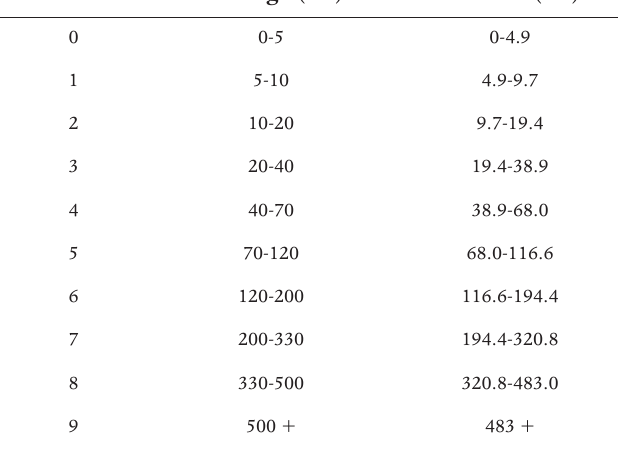
Table 1. Limit of range classes (expressed in nT) for the K index, for